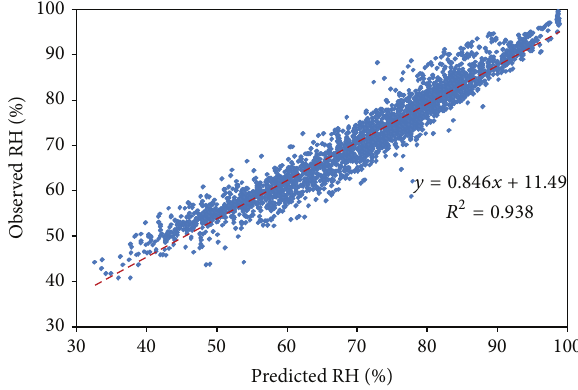
Figure 7: Comparison between observed and morphed hourly RH at site A.